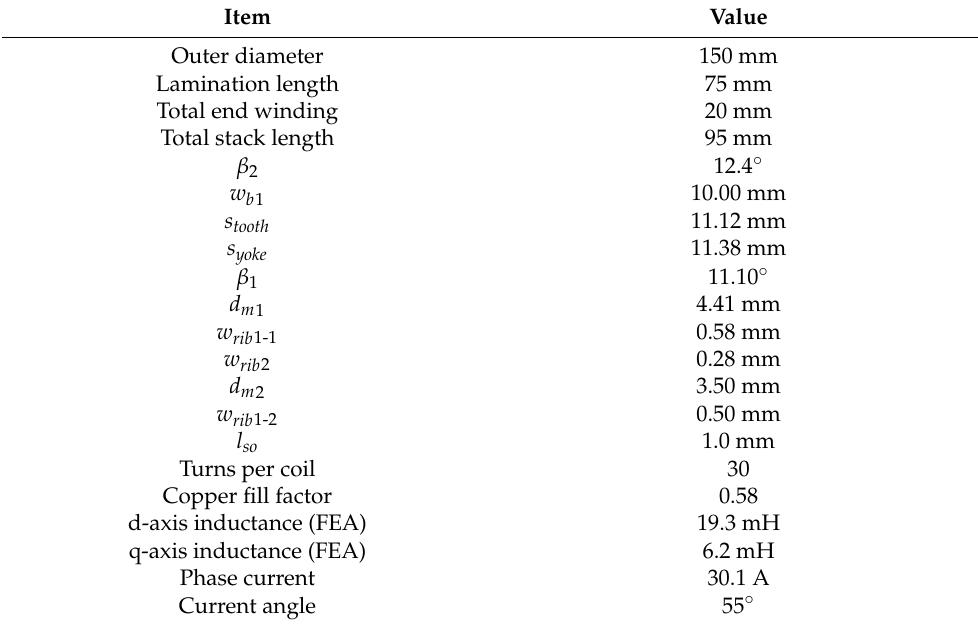
Table 1. Main Design Specifications of the 12/4 Machine.